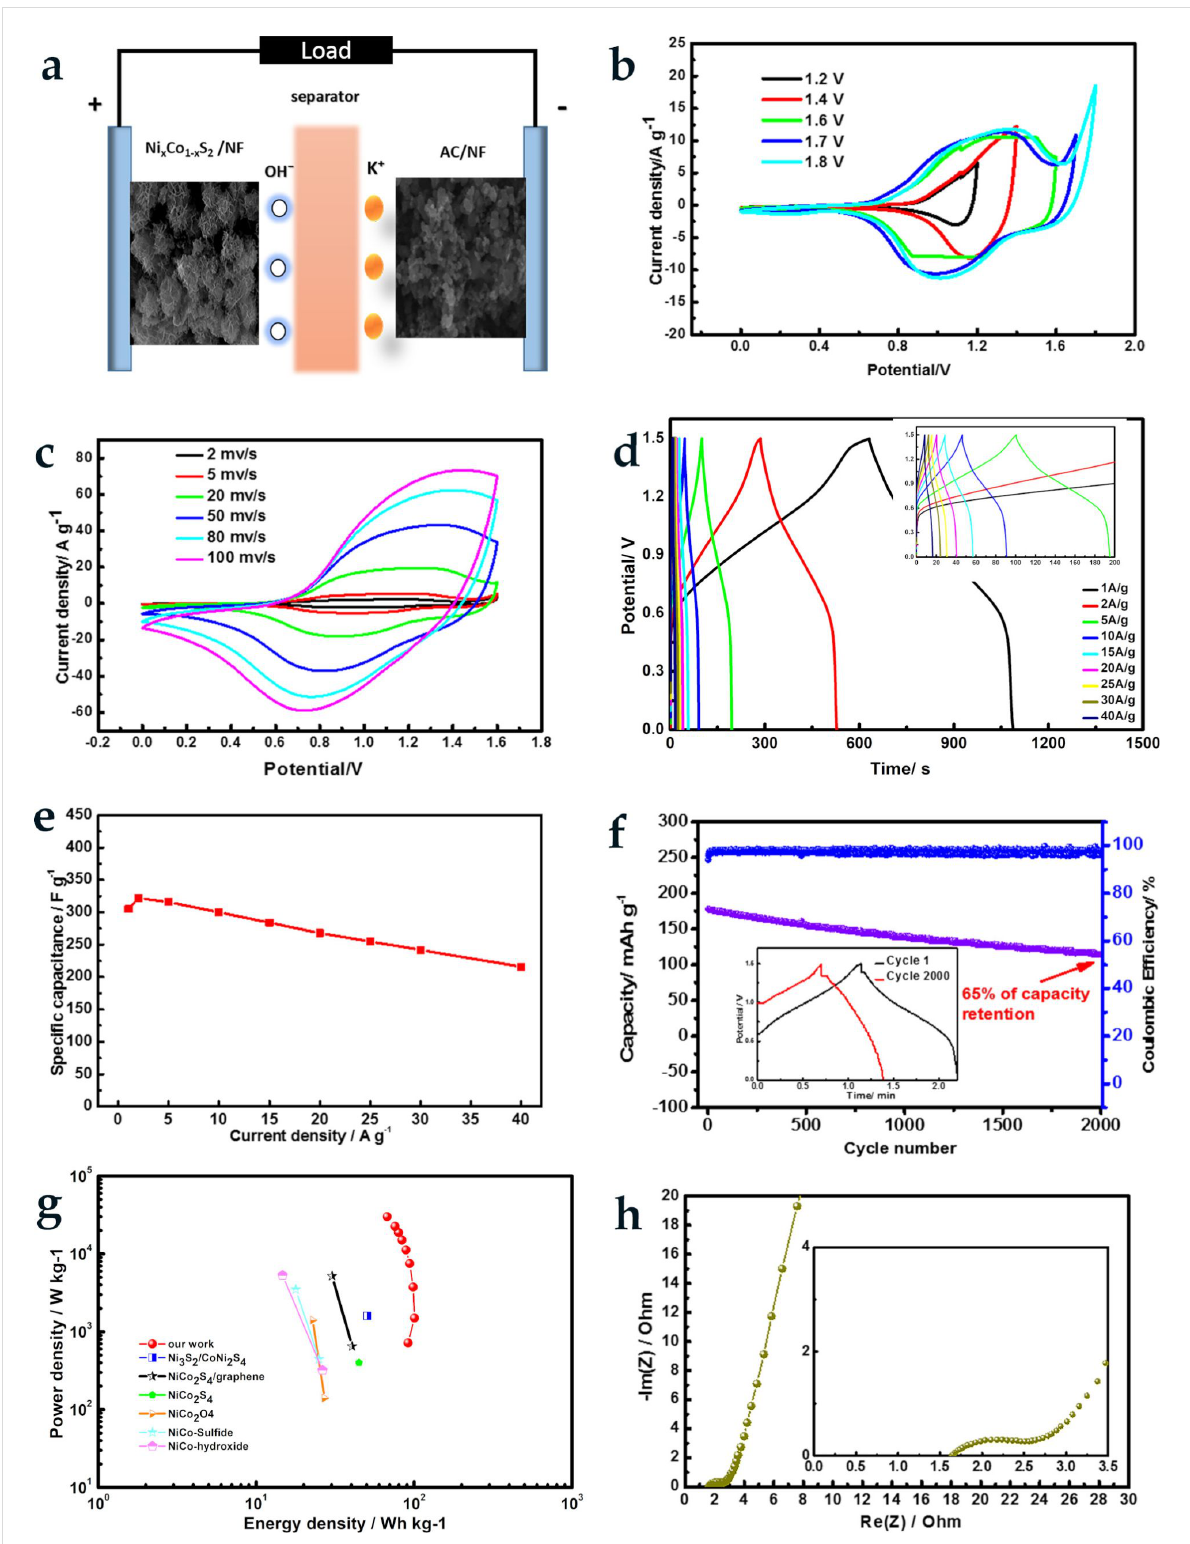
Figure 4: a) Configuration of the ASC; (b) CV curves of the ASC at different potential windows with a scan rate of 10 mV·s − 1 ; (c) CV curves of the device at various sweep rates and (d) GCD curves of ASC at different charging/discharge current densities; and (e) the corresponding specific capaci- tance, (f) cycling stability of the ASC under a current density of 10 A·g − 1 , (g) Ragone plot, and (h) EIS plot of the